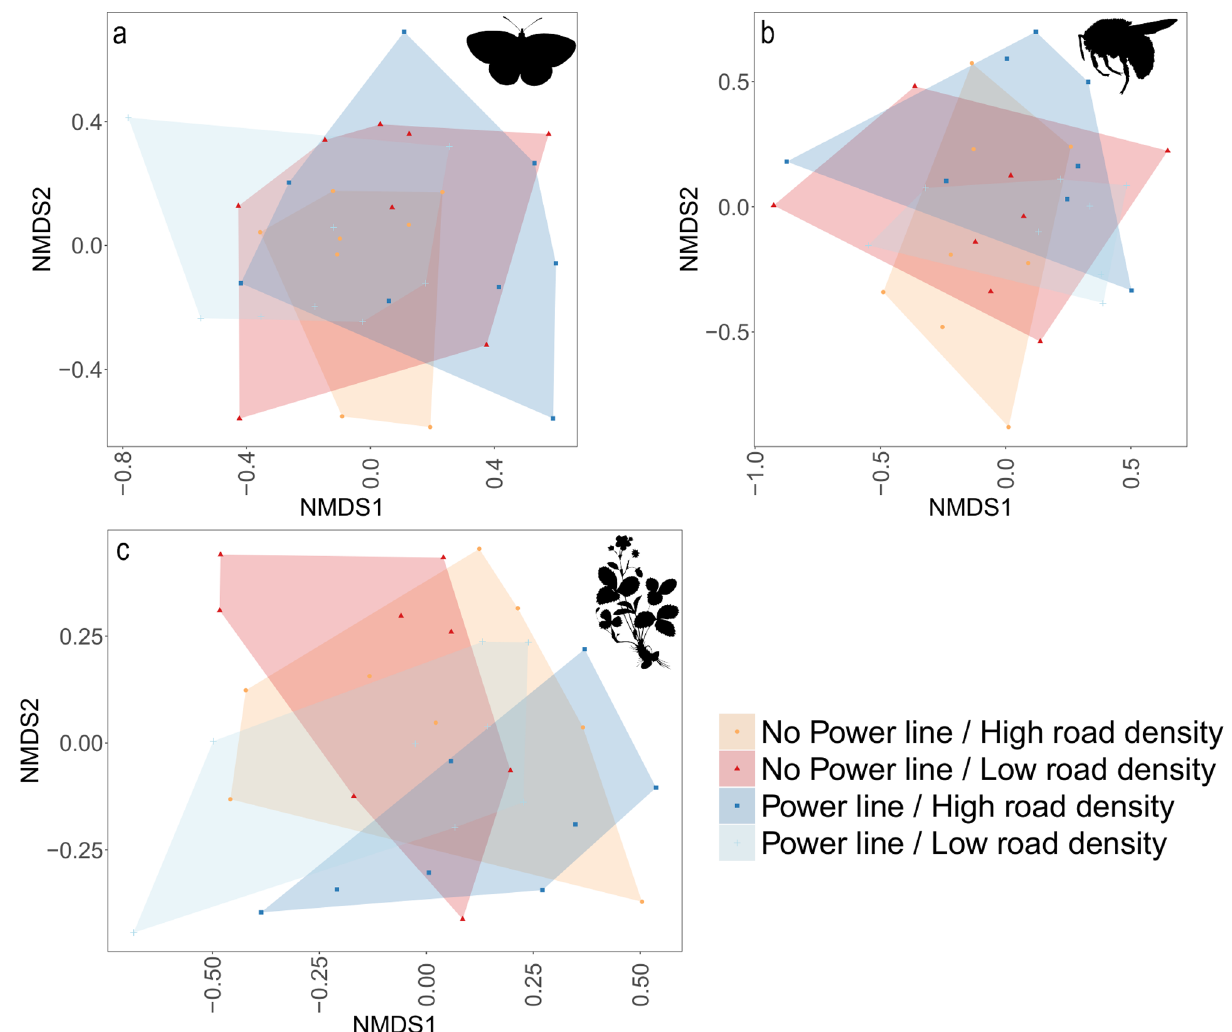
Figure 2. Non-metric multidimensional scaling (NMDS) analysis for butterflies ( a ; stress = 0.23), bumblebees ( b ; stress = 0.24) and plants ( c ; stress = 0.24) in the four landscape categories. There are not evident differences in the species compositions between landscape categories. See Supplementary Fig. S1–S3 for figures including species positions. Silhouette images were available under Public Domain license at PhyloPic (http:// phylo pic.